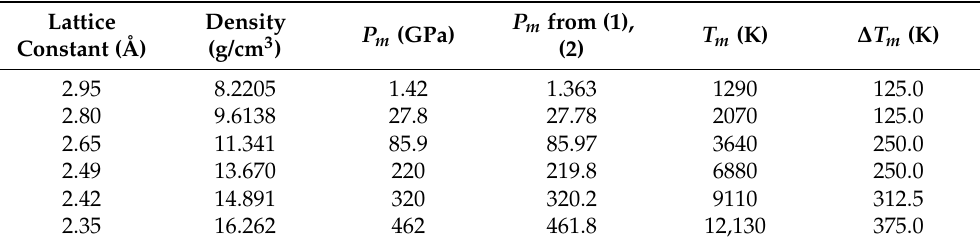
Table 2. The six ab initio melting points of bcc-Cu, ( P m , T m ± ∆ T m ) , obtained from the Z method implemented with